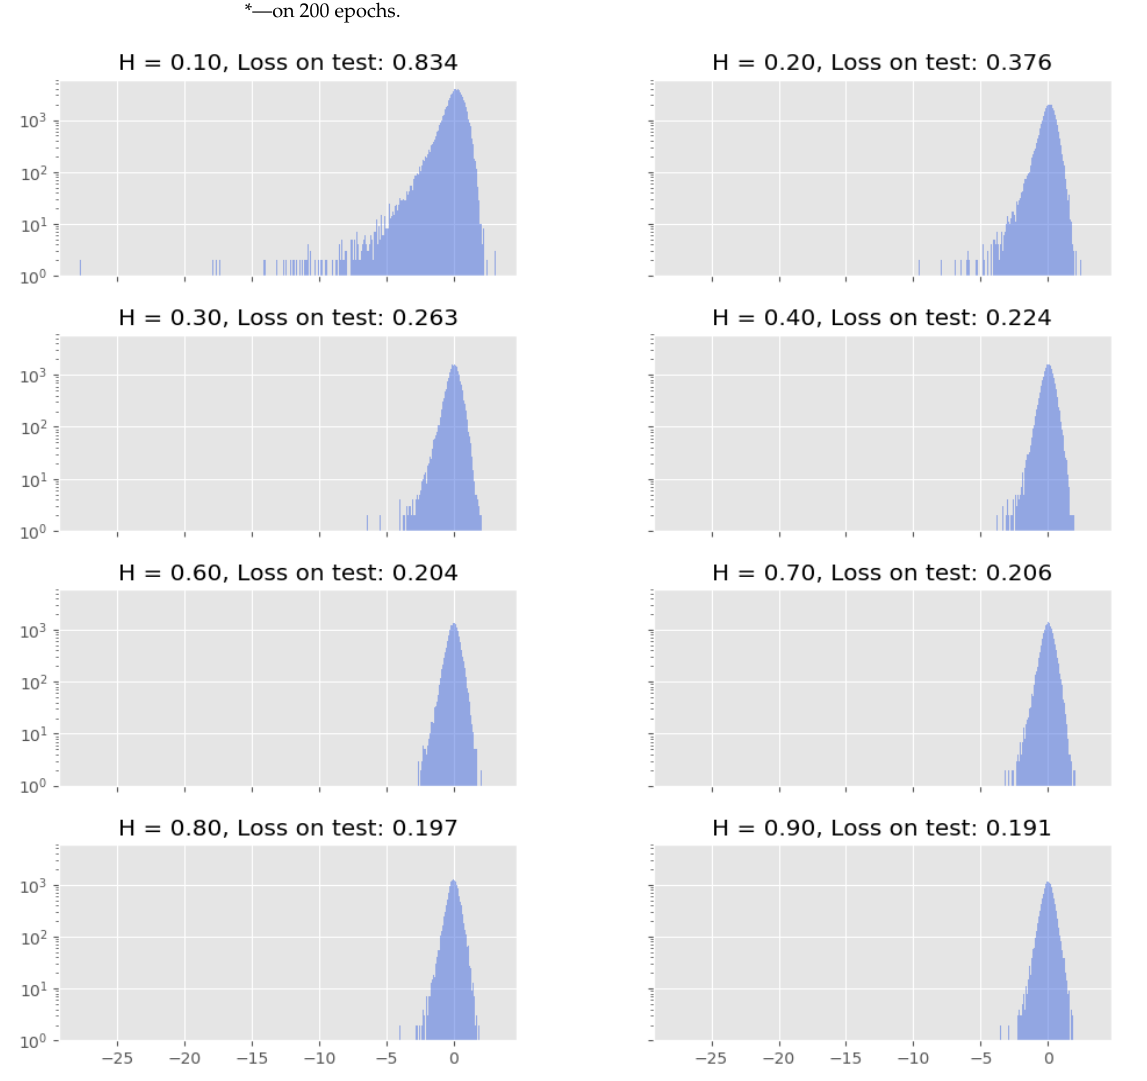
Figure 4. Empirical P&L distributions in log-scale for different Hurst parameters under the fRNN hedge. Loss on test denotes the realised quadratic loss on the test set for a network trained on 75